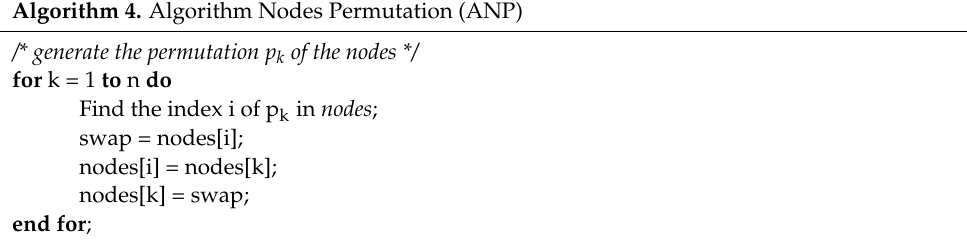
Algorithm 4. Algorithm Nodes Permutation